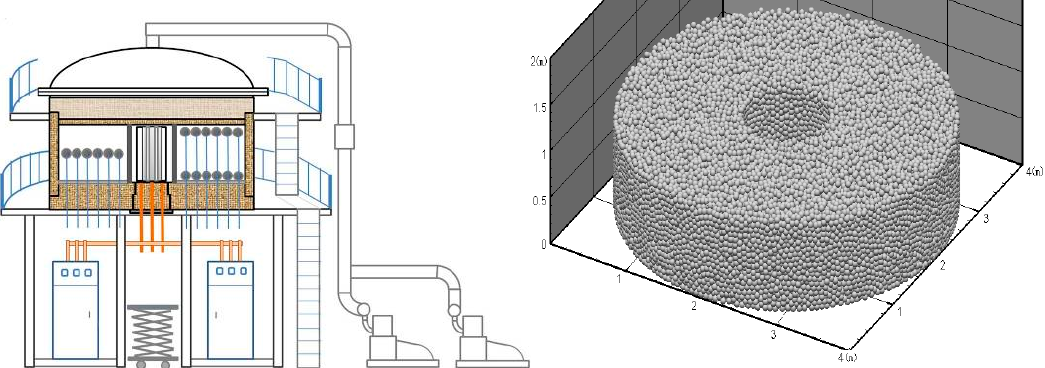
Figure 1. Structure diagram and pebble bed of the test facility for pebble bed equivalent conductivity measurement (TF ‐ PBEC).